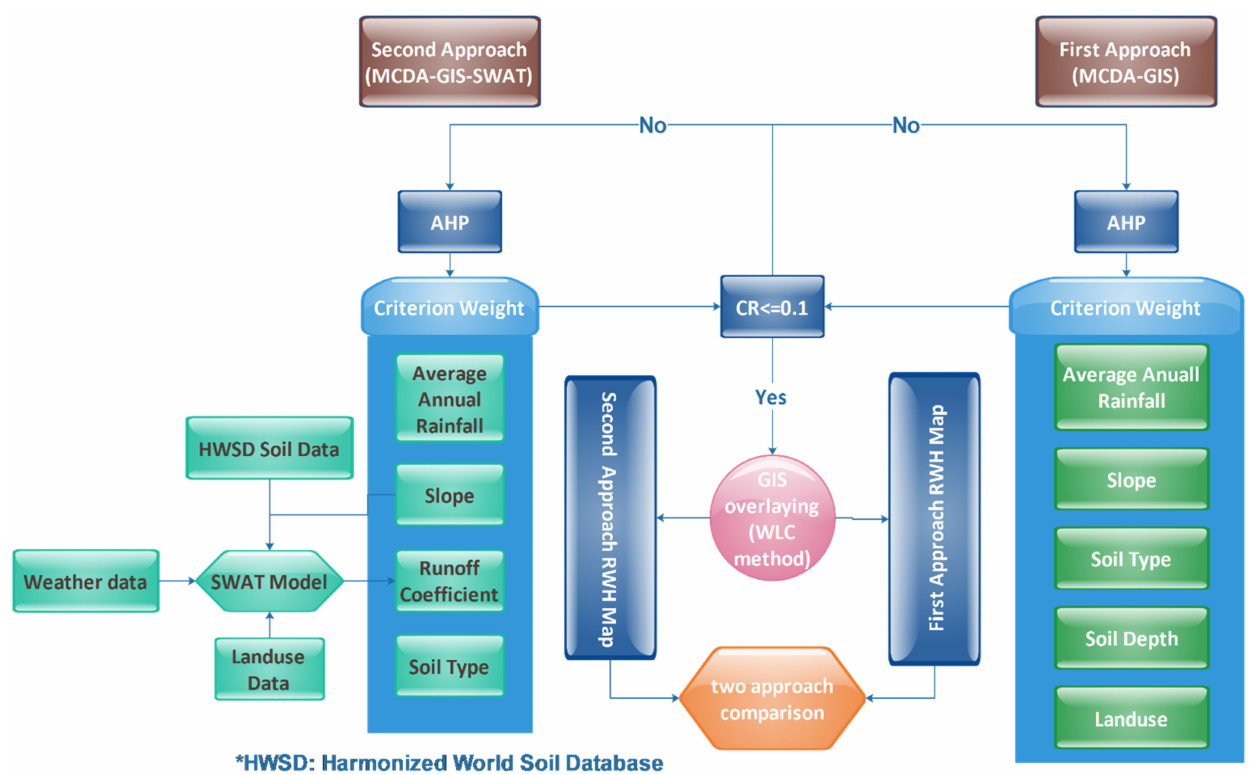
Figure 1. Conceptual methodology framework used in this